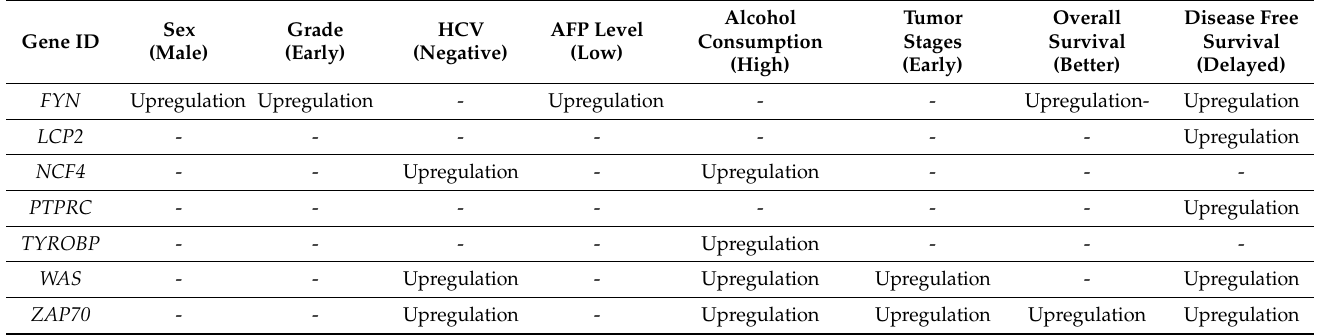
Table 2. Association of expression of seven genes signature with clinical features (Validation